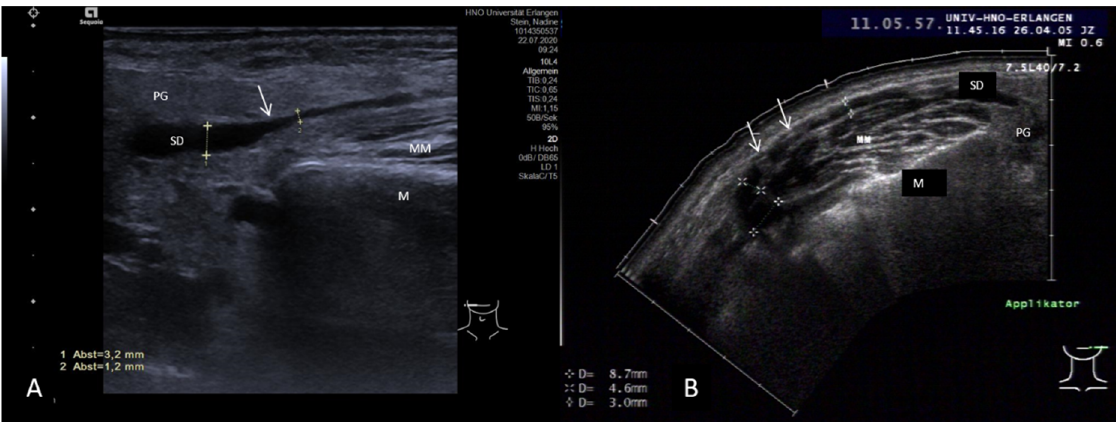
Figure 6. ( A , B ) Appearance of sialodochitis in two cases. A clear and sudden change (white arrow) in the lumen of Stensen’s duct with an increase from 1.2 to 3.2 mm is recognizable in ( A ). The parenchyma of the PG is slightly hypoechoic. ( B ) shows a case of chronic parotitis accompanied by duct dilation with an irregular shape of the duct wall caused by circular and semicircular encroachments. Due to their consistency (connective tissue), such encroachments appear as slightly hyperechoic structures (white arrows). These correspond to webs and/or strictures observable in sialendoscopy. The diameter of the duct can be very variable during its anatomical course. The parenchyma shows a tendency to be hypoechoic. Abbreviations: PG, parotid gland; M, mandible; MM, masseter muscle; SD, Stensen’s